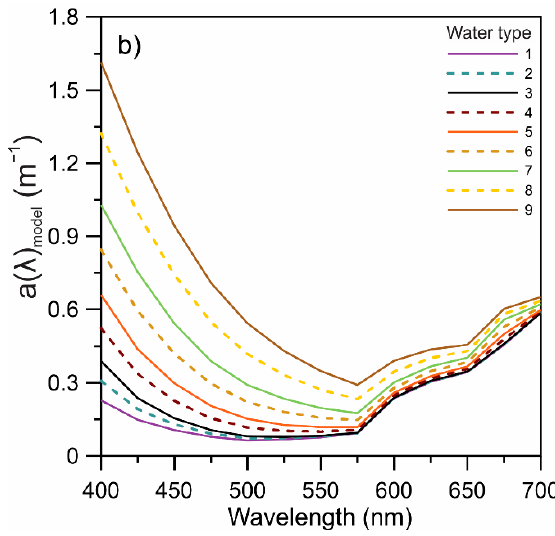
Figure 5. Intermediate water types (dashed lines), added to the original Jerlov coastal water types.